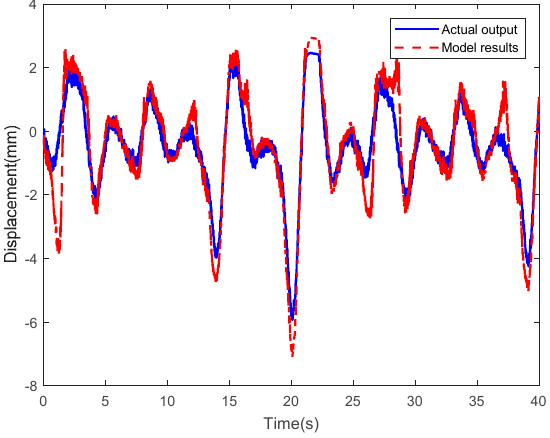
Figure 25. Results of the LSSVM ‐ NARX model at random sinusoidal actuating voltage I.